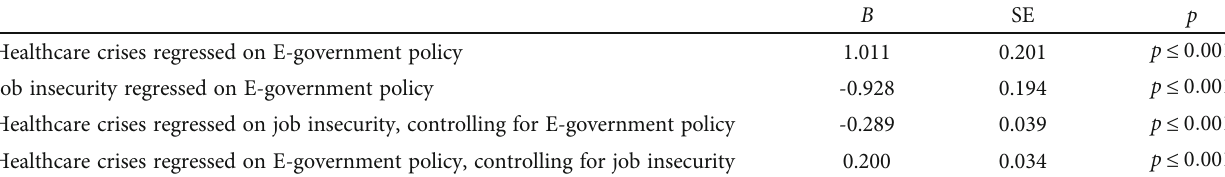
Table 4: Regression results for simple mediation.